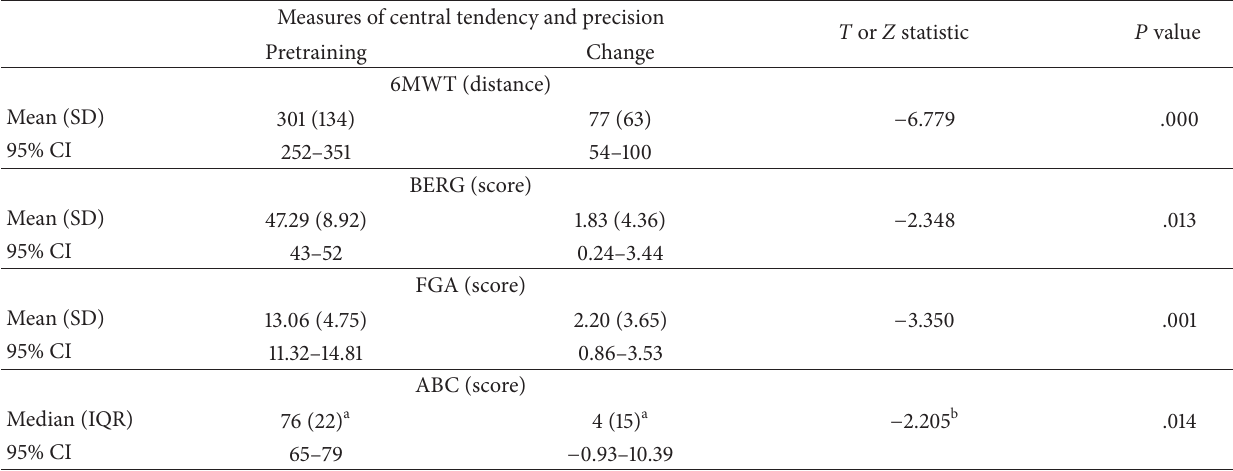
Table 2: Pretraining and change-score